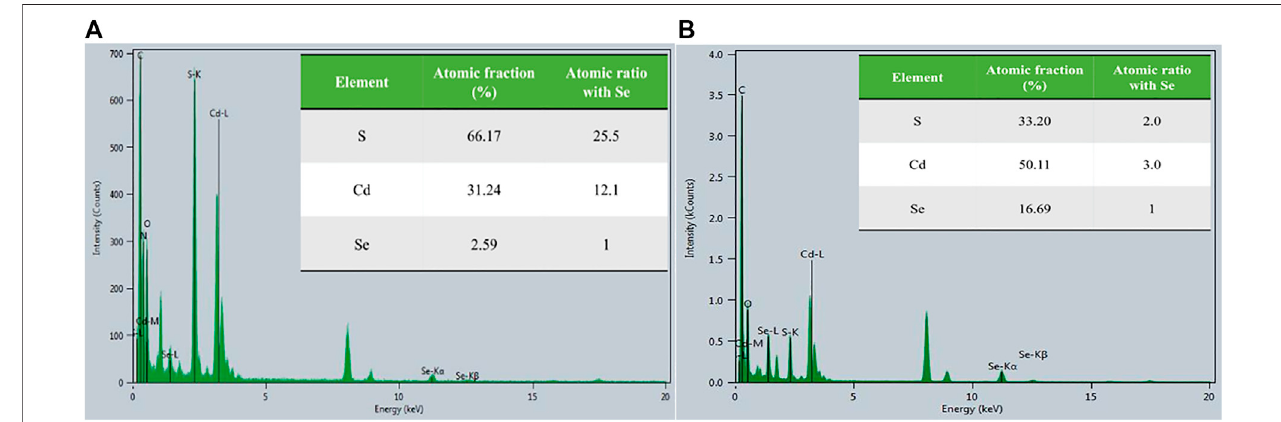
FIGURE 4 | Atomic spectra for L-cysteine capped CdSe NP in a dark condition (A) and in the light condition (B) . The inserted table shows the atomic fraction of scanned NP and the atomic ratios relative to Se.